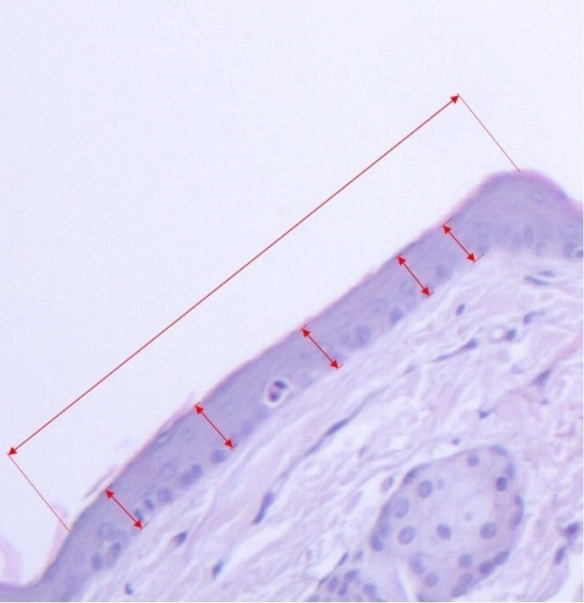
Figure 3. Section group treated with 0.1 milliliter celecoxib 2% applied in the proximal part of the tail. The granular layer extends on the whole length scale, hematoxylin–eosin staining, 10× objective.